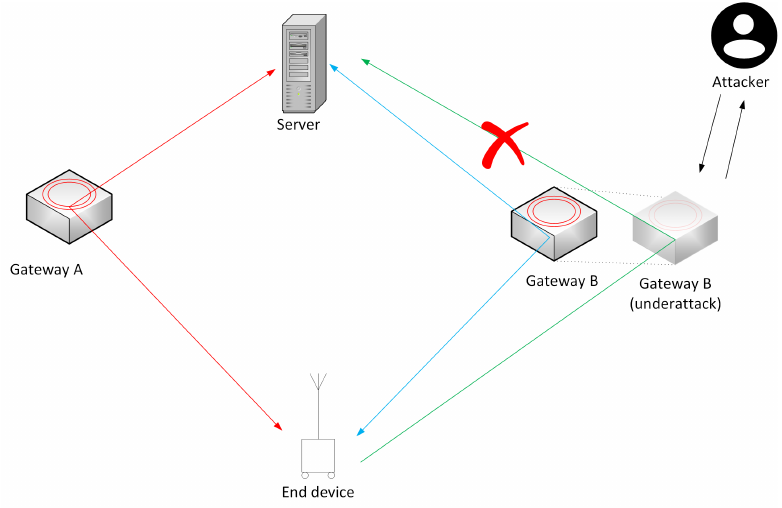
Figure 7. Scenario of packet advancement under MITM attack.